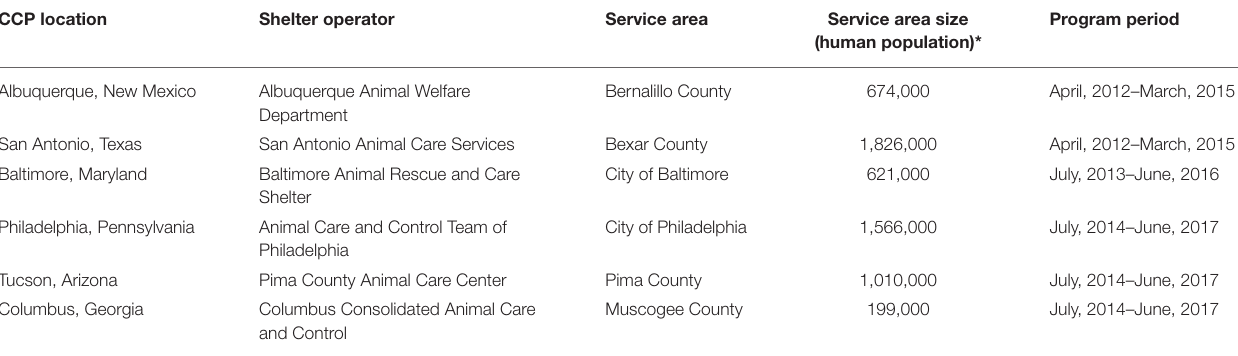
TABLE 1 | Community Cat Program (CCP) locations, shelter name, service areas and size, and program periods. CCP